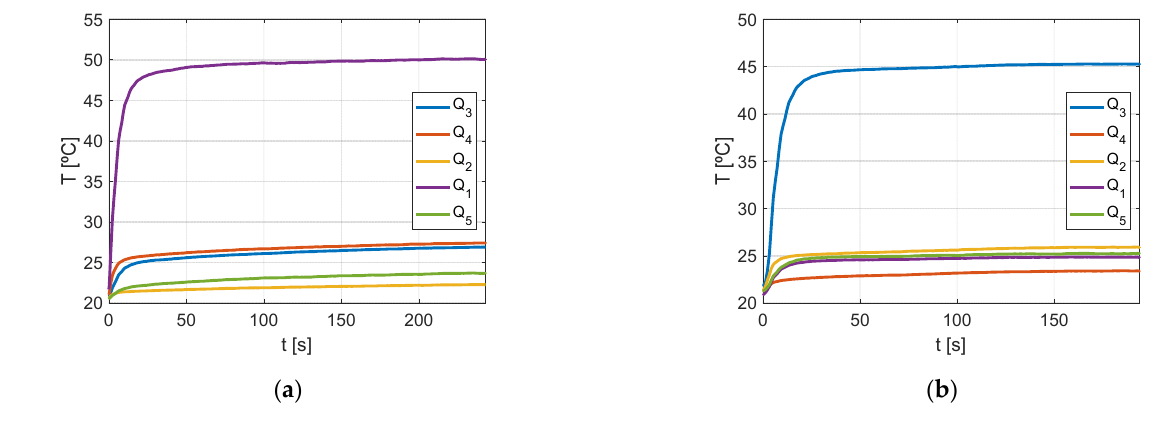
Figure 14. Semiconductors’ temperature evolution at the MSIBC. ( a ) FPC. ( b ) PPC. Table 9. Experimental power loss, efficiency, and K pr results obtained with the double-inductor topology. Parameter